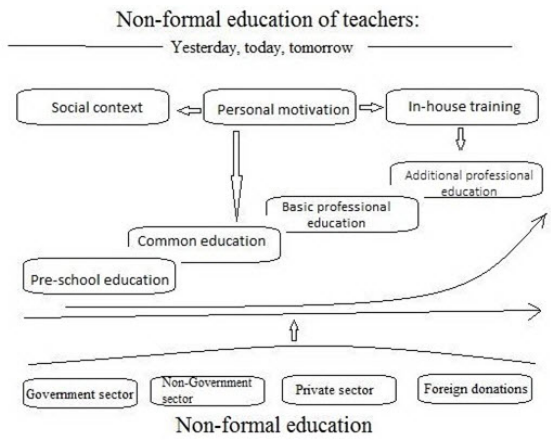
Figure 1. Non-formal education as a segment of lifelong